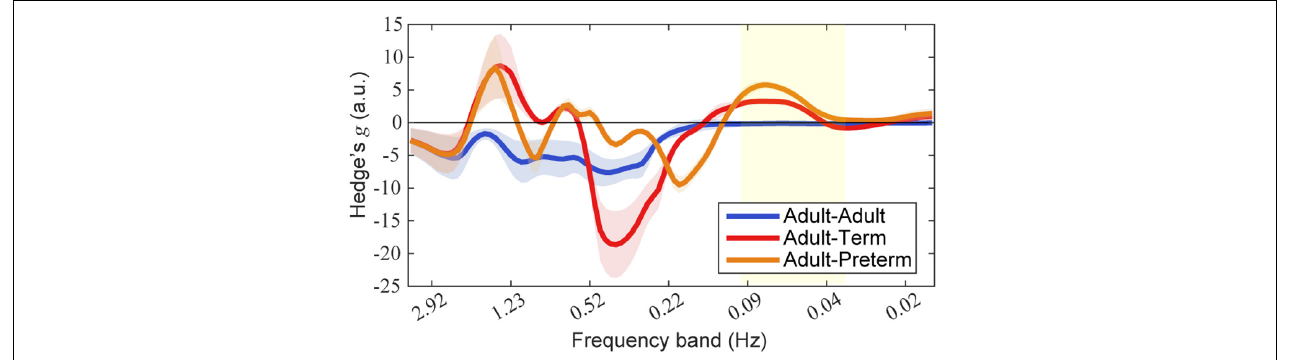
FIGURE 6 | Effect size of prewhitening on wavelet coherence. Each mean and standard deviation of Hedge’s g over seven types of event-number conditions are presented as a line and shaded area, respectively. Blue, red, and orange lines indicate dyads of adult–adult, adult–term, and adult–preterm conditions, respectively. The yellow area indicates the targeted frequency bands (0.03–0.1 Hz). Note that a positive value indicates that prewhitening led to an increase in